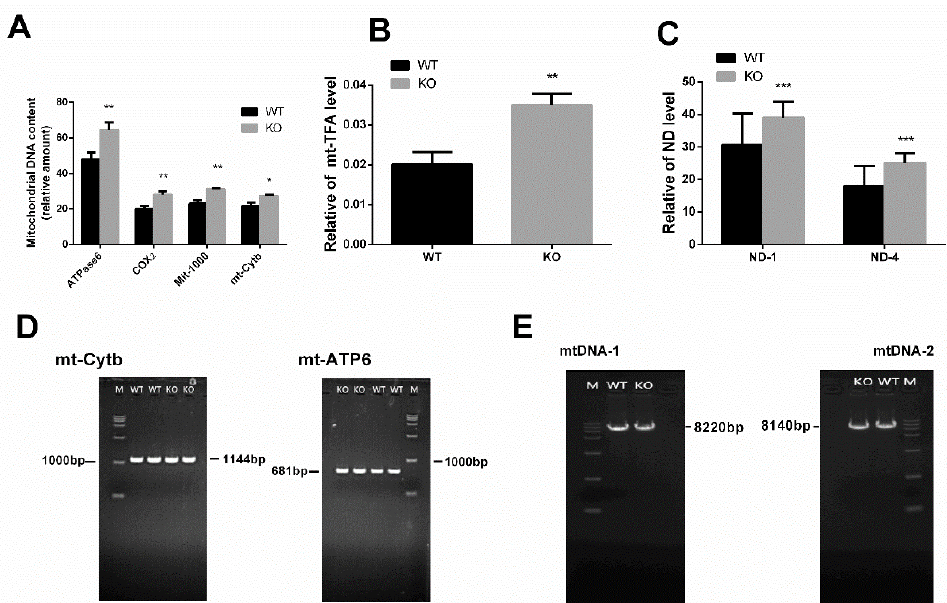
Figure 3. miR-125b-2 affected mtDNA’s copy number and integrity. ( A ) MtDNA copy number in the sperm of the KO and WT mice. ( B ) The relative expression of mitochondrial transcription factor A (mt-TFA) ( n = 8). ( C ) Quantifications of ND1 and ND4 mRNA levels in sperm. ( D ) PCR amplification products of mtCytb (left) and mtATP6 (right) in the sperm of KO and WT mice. M: DL2000 DNA marker. ( E ) 8220 bp (left) and 8140 bp (right) of the mtDNA amplification products in the sperm of KO and WT mice using long PCR. M: DL15000 DNA marker. The asterisk indicates a statistically significant difference at * p < 0.05, ** p < 0.01, *** p < 0.001.